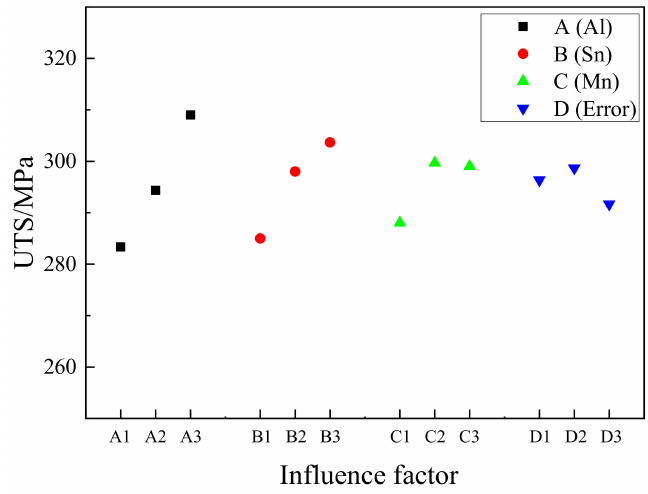
Figure 11. Factors and Index trends diagram of UTS for nine trial